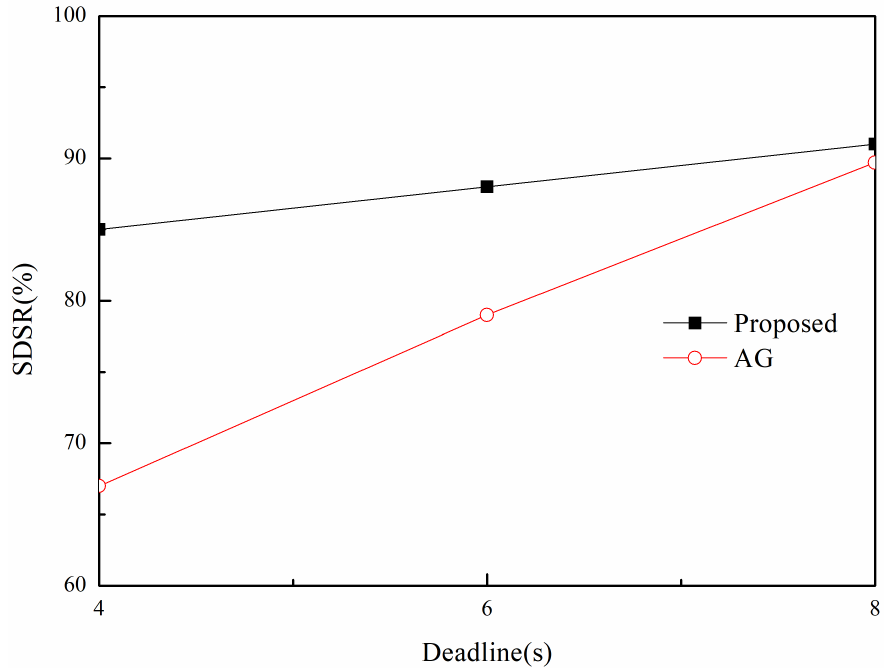
Figure 11. SDSR in (2,3)-firm application as a function of